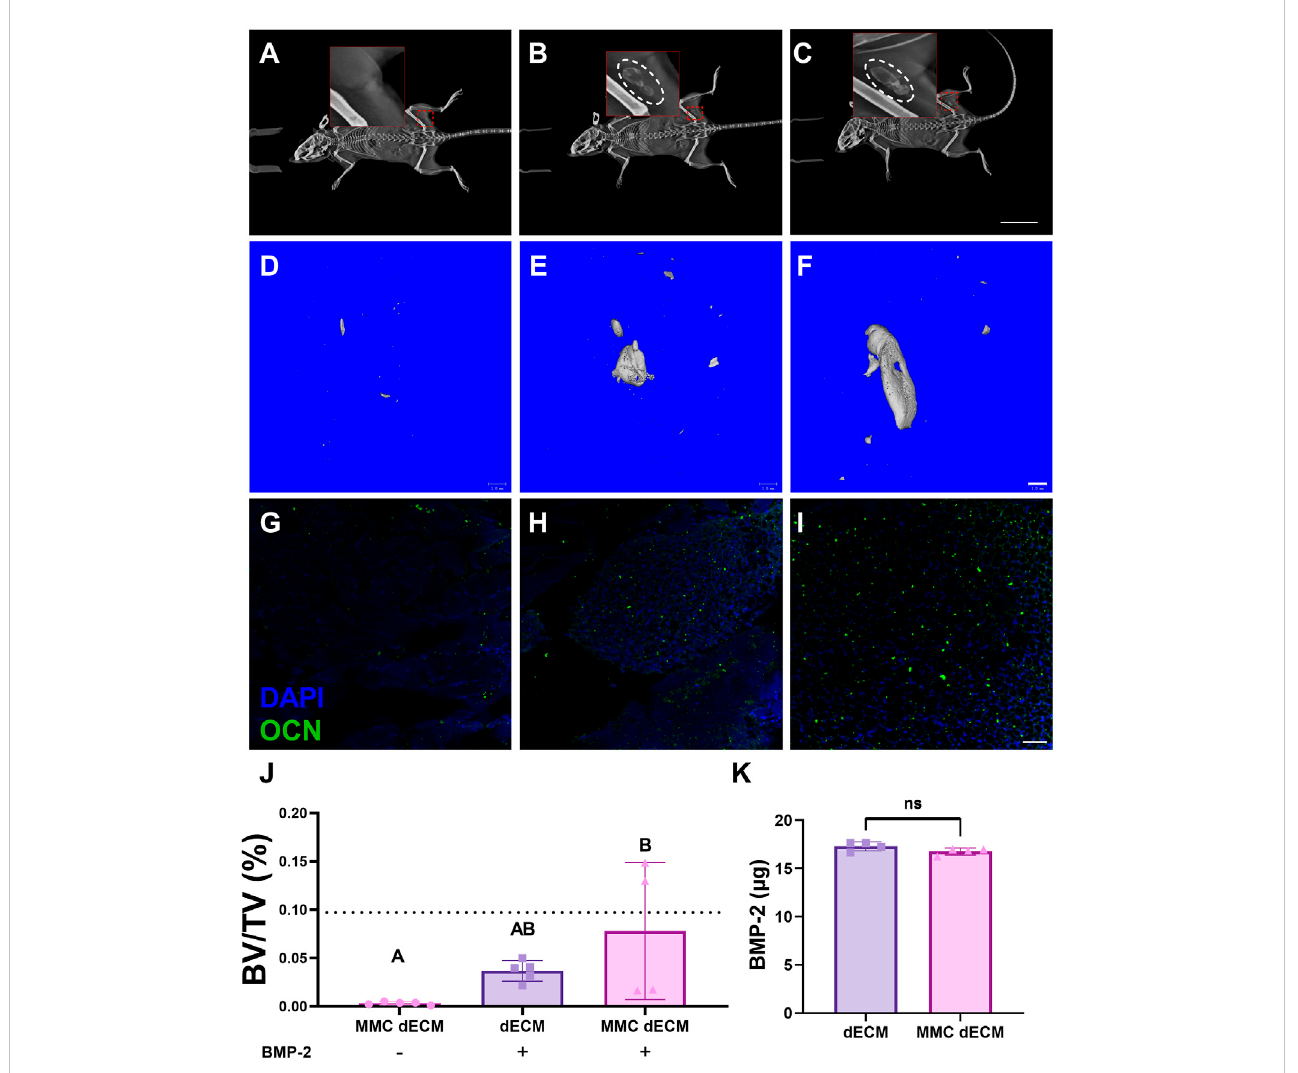
FIGURE 4 MineralizedtissueisincreasedinthemurinemusclepouchwhenimplantedwithMMCdECMandadsorbedBMP-2. (A – C) Radiographsweretakenatday 28 in live animals. Hashed white circles denote areas with mineralized tissue in (A) MMC dECM, (B) dECM + BMP-2, and (C) MMC dECM + BMP-2. Scale bar is 20 mm. (D – F) MicroCT reconstruction reveals mineralized tissue generated in (D) MMC dECM, (E) dECM + BMP-2, and (F) MMC dECM + BMP-2. Scale bar is 1 mm. (G – I) Tissuesectionsstainedforosteocalcin(OCN,green)andDAPI(blue)inbicepsfemoriscontaining (G) MMCdECM, (H) dECM+BMP-2,and (I) MMC dECM + BMP-2. Scale bar is 50 µm. (J) Quanti fi cation of bone volume fraction in the interrogated volume. Dotted lines denote the mean value of HA groups. (K) Quanti fi cation of BMP-2 adsorbed to ECMs for in vivo study. Data are mean ± SD ( n = 4 – 5). Groups with different letters denote statistical signi fi cance as determined by one-way ANOVA or Student ’ s t -test as